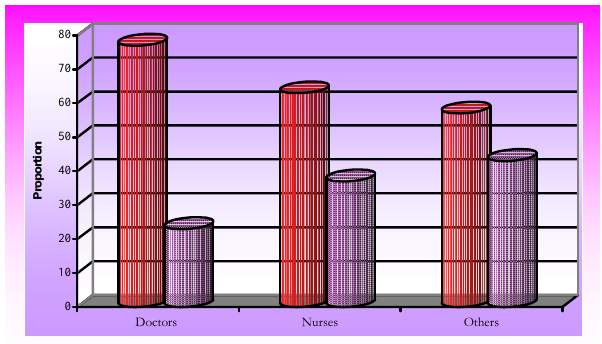
Figure 4: Average global urban-rural distribution of health service